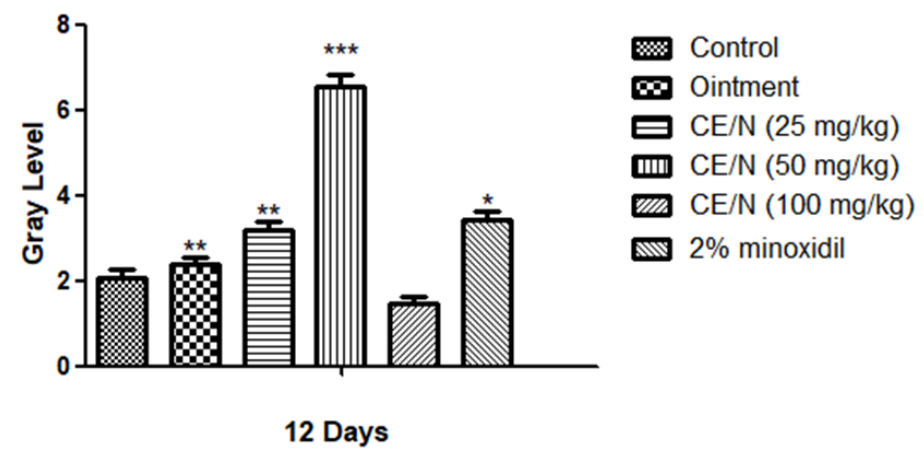
Figure 5. Grayscale analysis in alopecia. The back skin were topically applied with ointment, CE-NE (25 mg/kg, 50 mg/kg and 100 mg/kg), 2% minoxidil. Photographs and analyzes were taken on 12 days after applying cedrol on the shaved dorsal skin. The results were shown as the mean values ± S.D. * p < 0.05, ** p < 0.01, *** p < 0.001, when compared to respective control values by Student’s t -test ( n = 6).